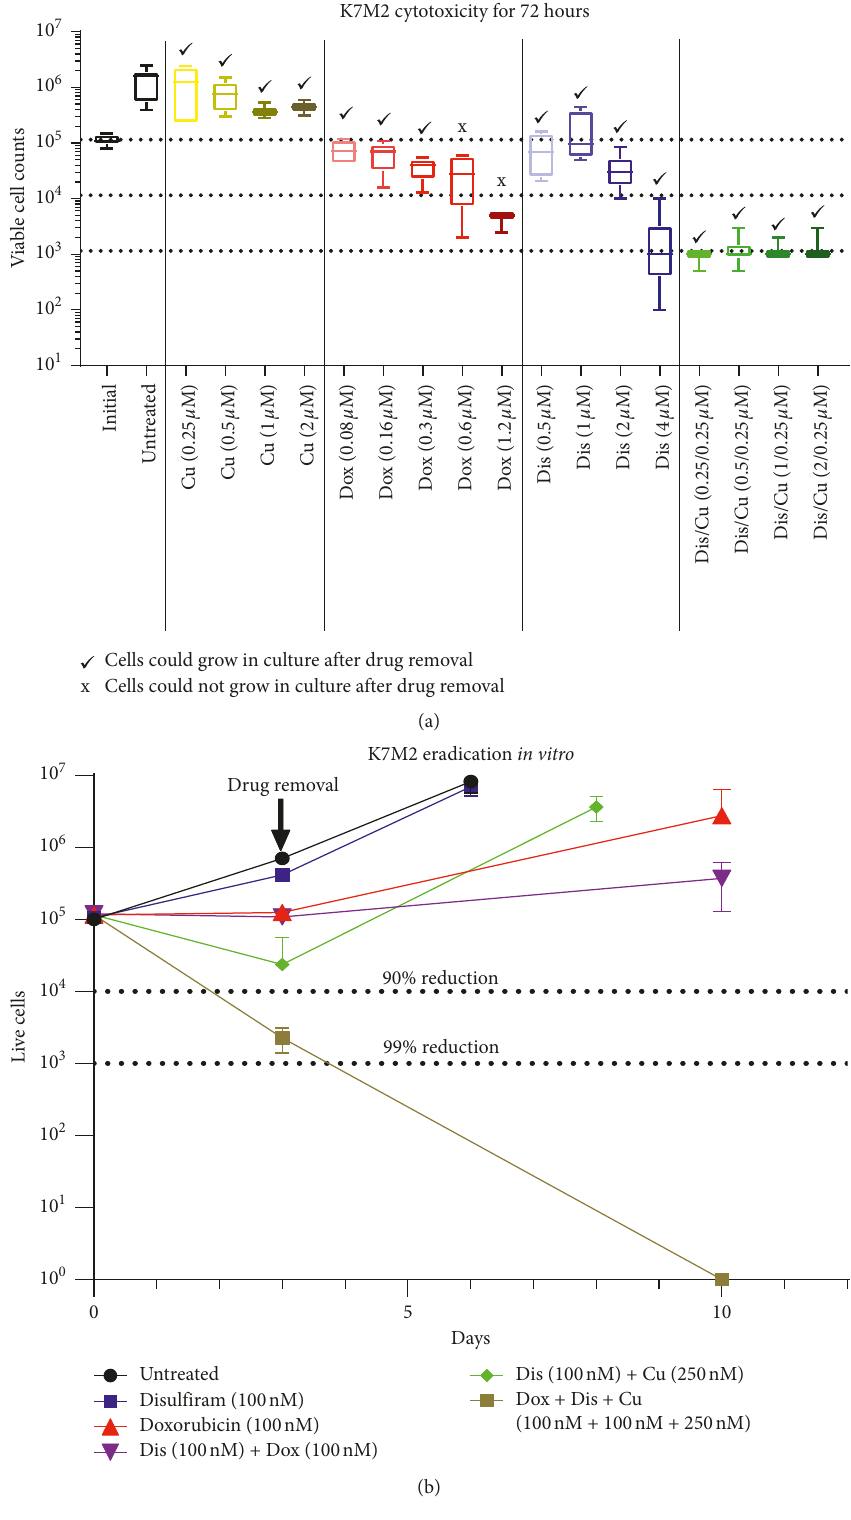
Figure 4: Combination treatment of doxorubicin, disulfiram, and copper chloride effectively reduces viability of K7M2 cells and eliminates recovery in vitro . (a) K7M2 OS cells were treated with CuCl 2 (0.12–2 μ M), Dox (0.02–1.2, 5 μ M), Dis (0.5–4 μ M), and Dis+CuCl 2 (0.12 and 0.25 μ M) for 72hours. After treatment, trypan blue exclusion staining was performed to obtain viable cell counts. Cells were cultured again in fresh media without drugs present and monitored for cellular growth. Dis potentiated with CuCl 2 clearly killed the most cells over 72hours, but all could subsequently recover in culture. (b) Dox and Dis combination treatment also allowed for cellular recovery in vitro , but triple treatment with Dox, Dis, and CuCl 2 resulted in over 90% killing over treatment duration and treated cells did not recover after drug removal. Experiments were performed using three independent cell cultures ( n � 3 )